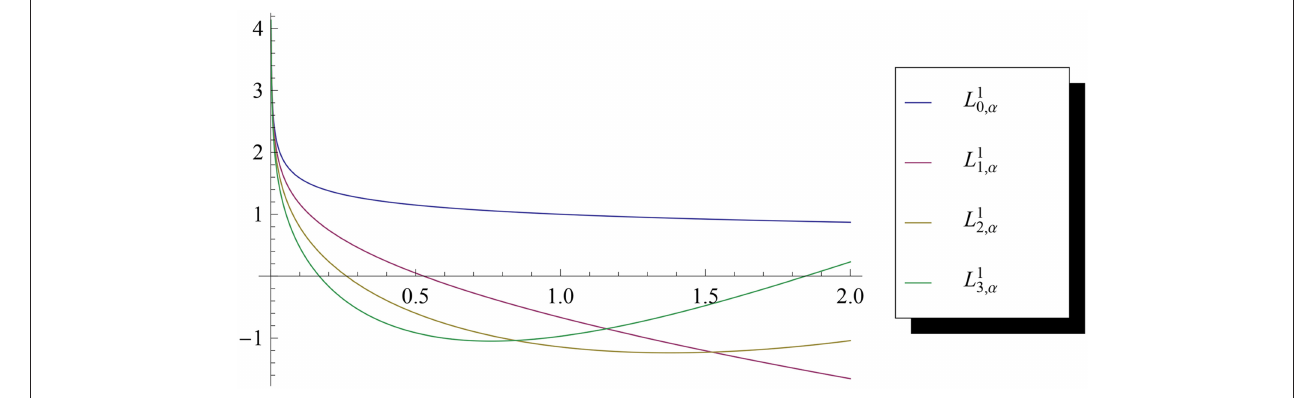
FIGURE 2 | A plot of L 1 0, α , L 1 1, α , L 1 2, α , L 1 3, α for α = 0.8.